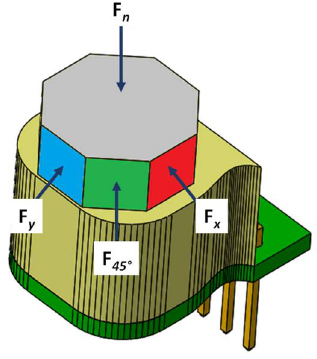
Figure 9. Applied force illustration using the octagonal dome.